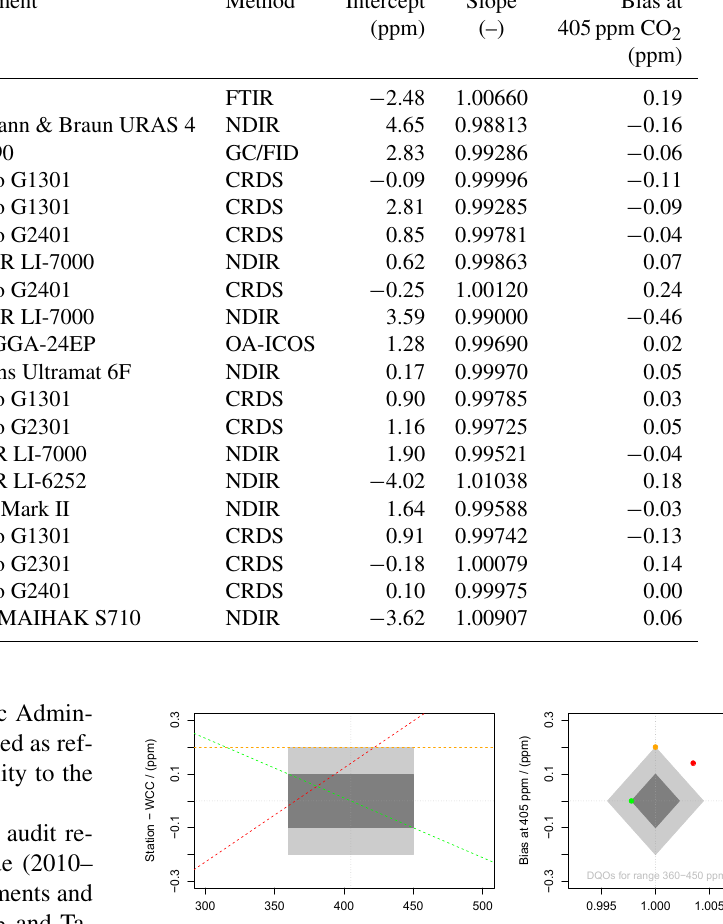
Table 1. CO 2 performance audits using travelling standards from 2010 to 2015. Station